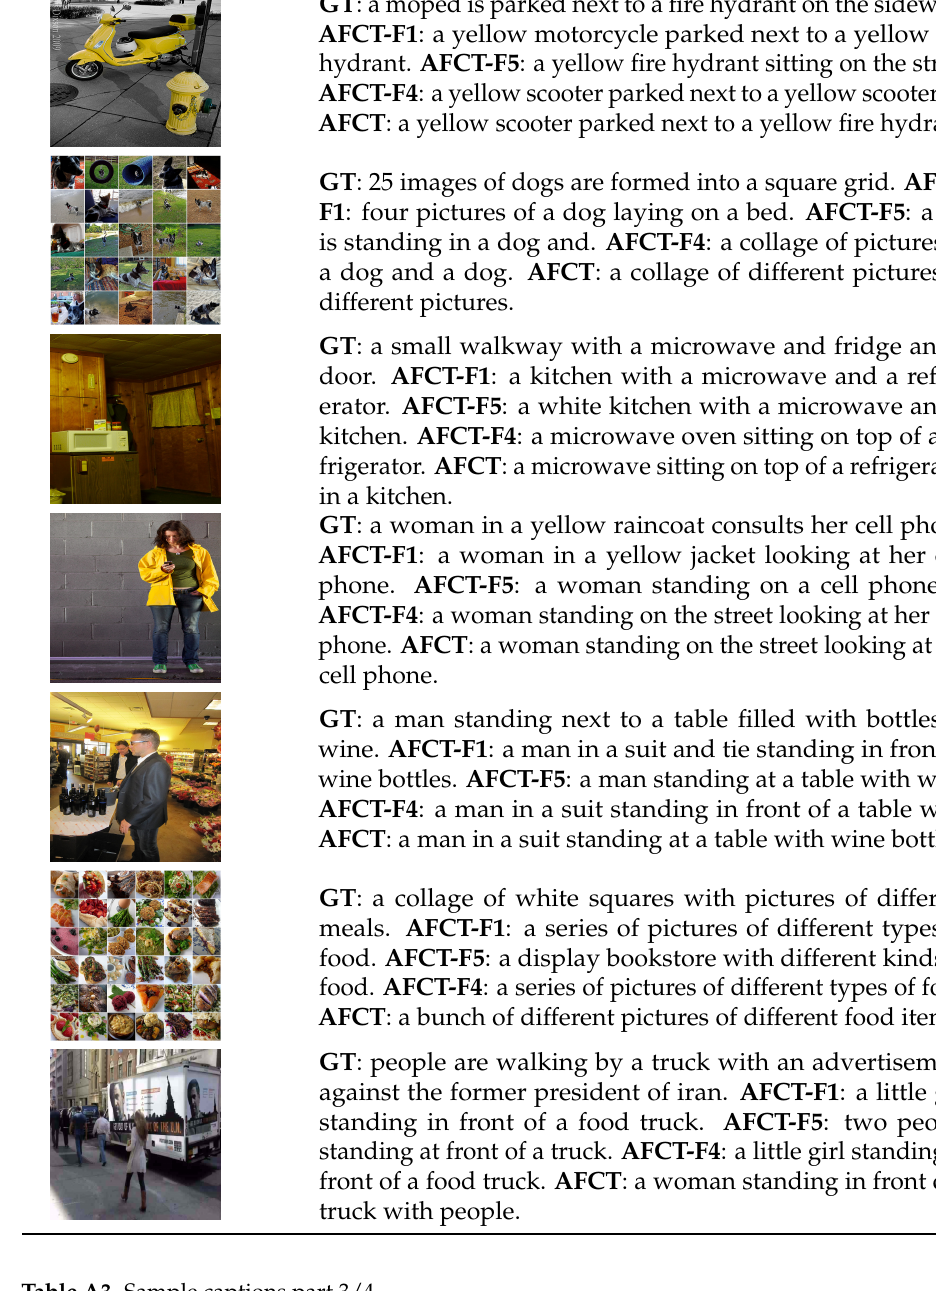
Table A3. Sample captions part